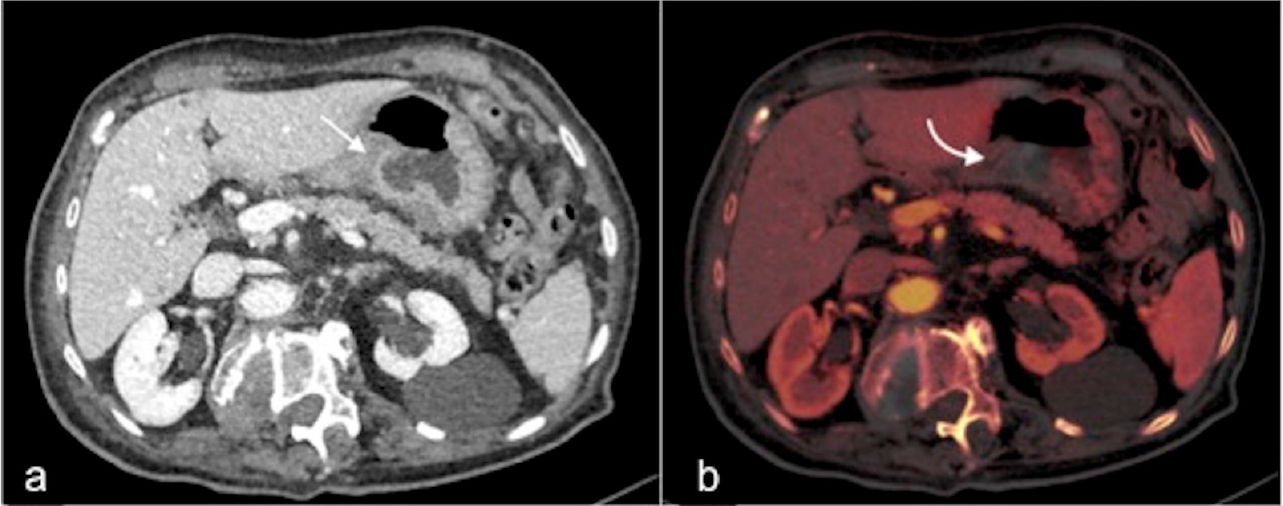
Figure 26. CTA multiphasic study of gastric GIST. In the pre-contrast ( a ), arterial ( b ) and venous (c) phases a large vascularised lesion in the gastric body with massive haemorrhagic lumen inunda- tion is visible.